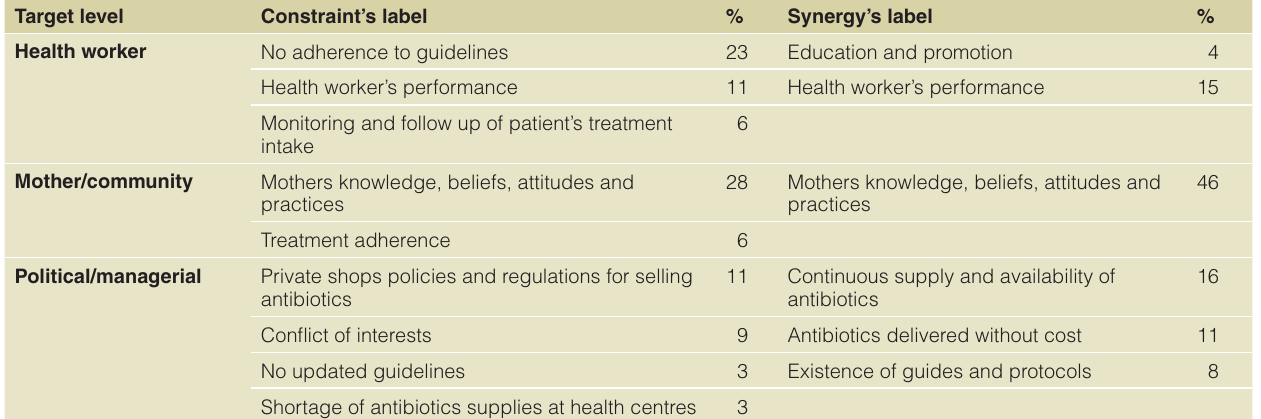
Table 3. Classification of identified antibiotic treatment of pneumonia (ATB-Pn) related constraints and synergies according to their target level and label together with the percentage of respondents that agreed with each label. Target